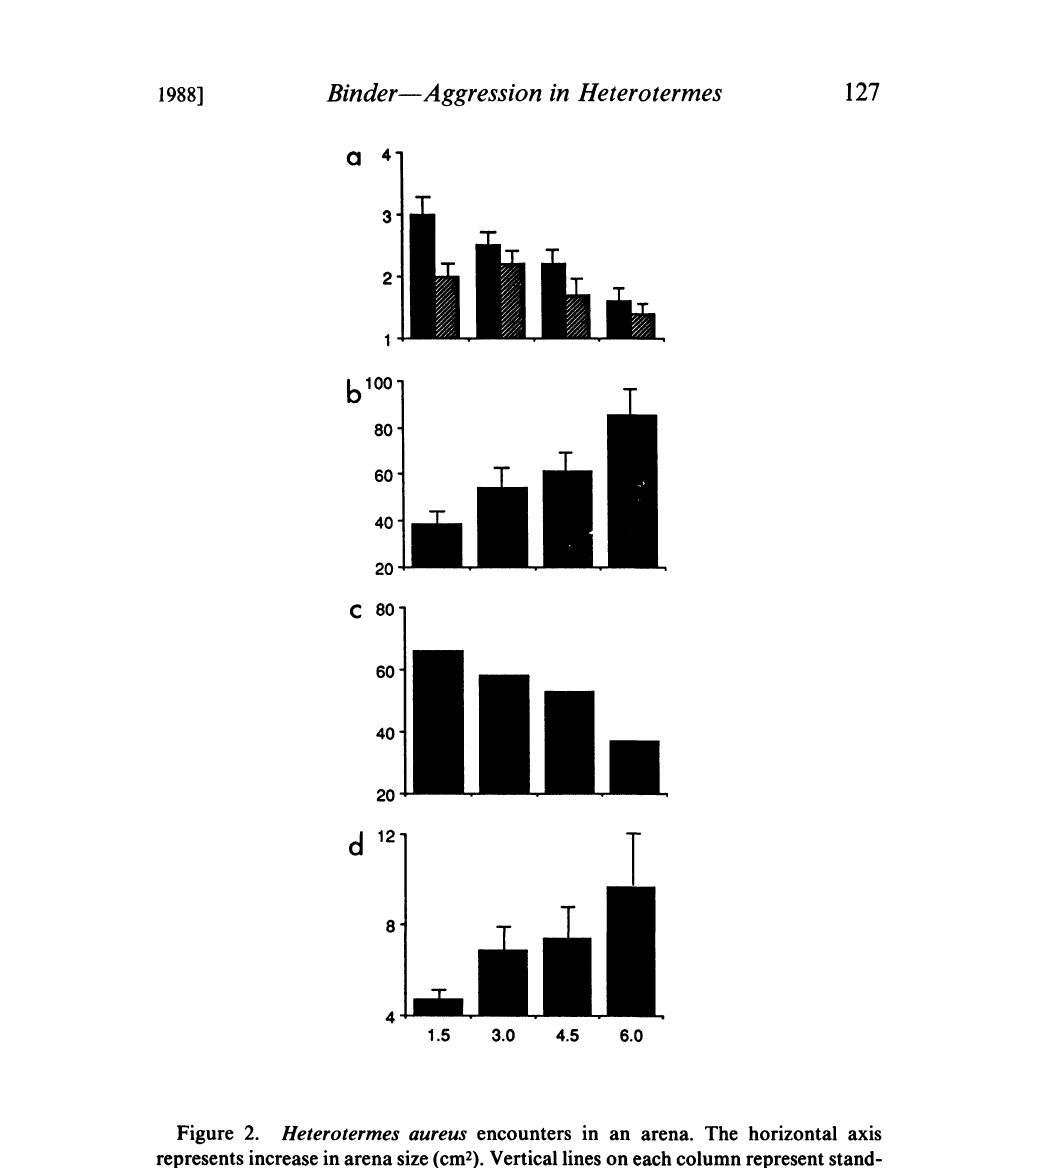
Figure 2. Heterotermes aureus encounters in an arena. The horizontal axis represents increase in arena size (em2). Vertical lines on each column represent stand- ard error, a) Intraeolonial (hatched) vs intercolonial (solid) mean number of encounters per minute, b) Mean time soldiers require to inflict fatal snaps on alien workers (seconds). e) Percentage of soldier encounters following a fatal snap against a worker, d) Mean number of snaps a soldier requires to inflict a fatal snap on a